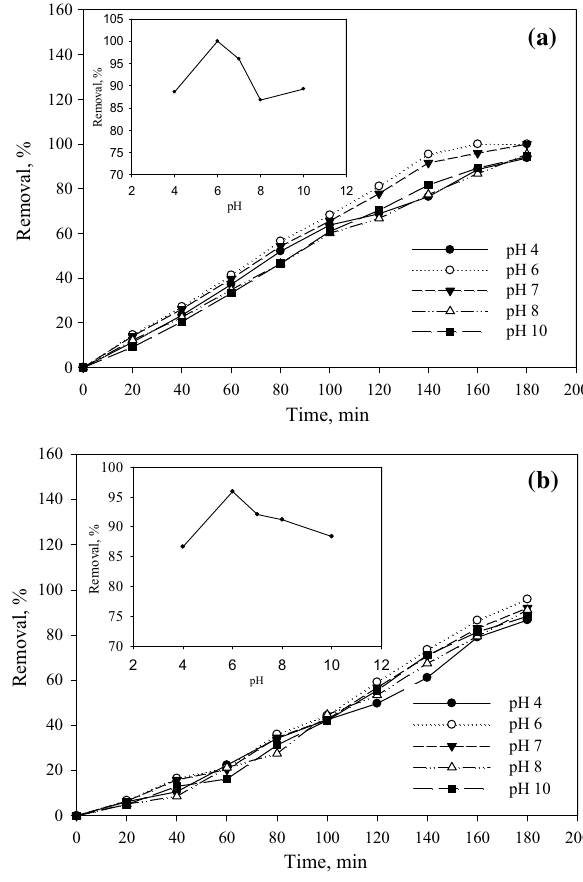
Fig. 7 Effect of pH on the rate bleaching ( a ) and dye degradation ( b ) of MO for 200 mg L −1 photocatalyst, methyl orange 10 mg L